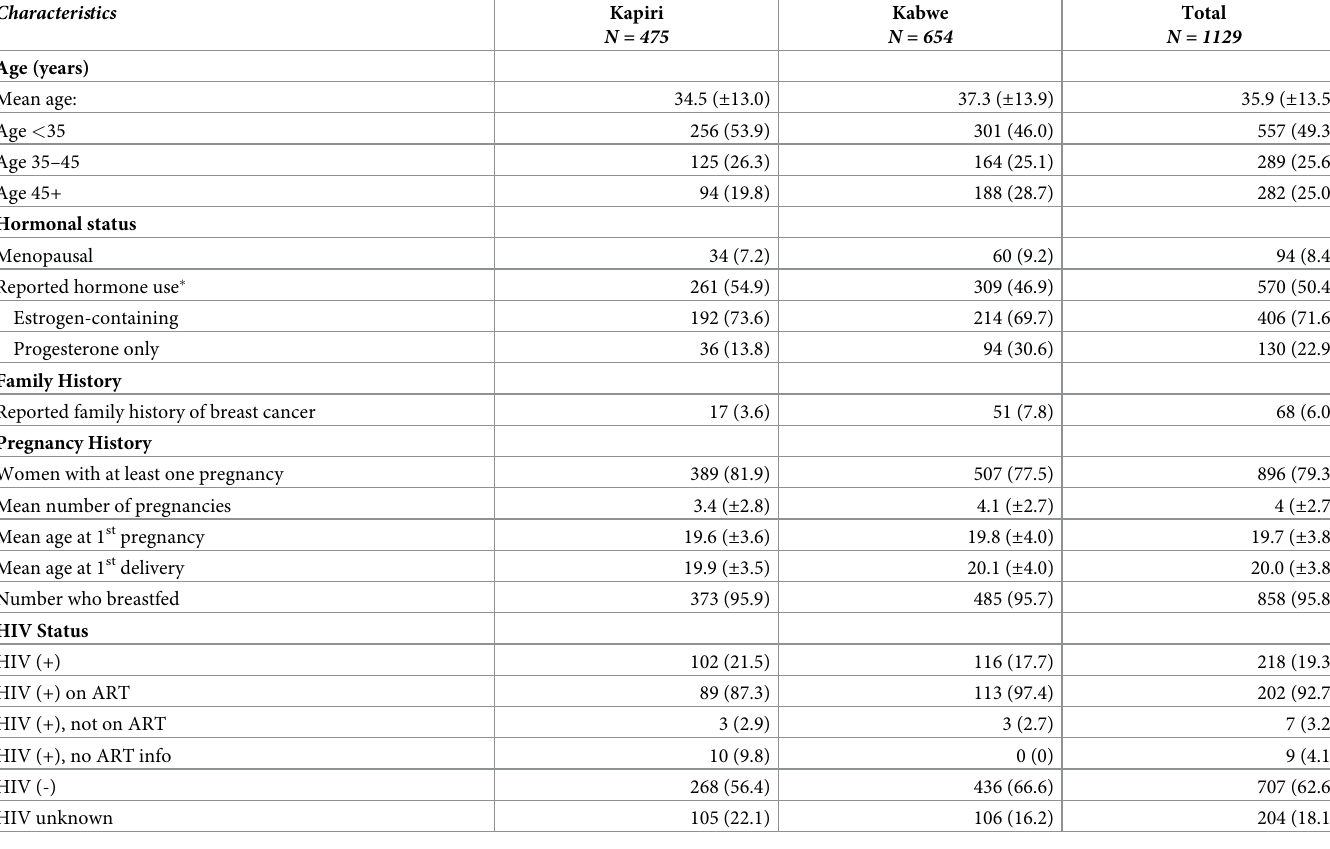
Table 1. Demographics of breast camp